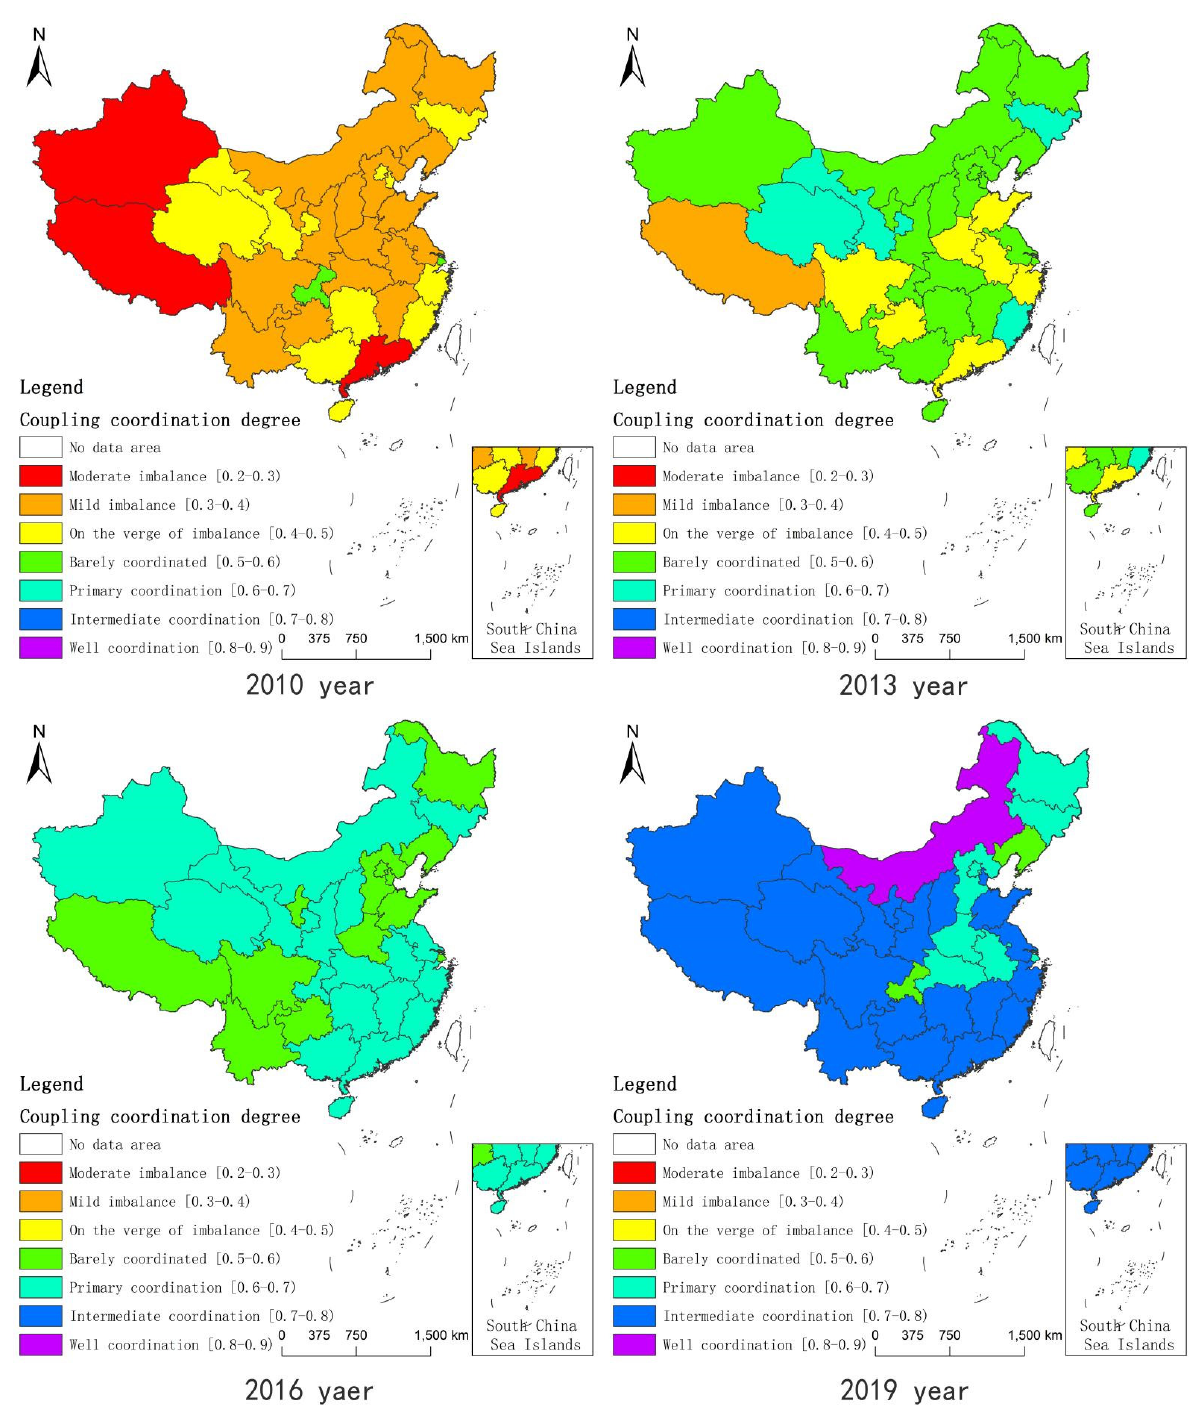
Figure 2. The spatial distribution of coordination state of various provinces and cities in China in 2010, 2013, 2016 and 2019. Source: map data obtained from the China National Geographic Information Center.